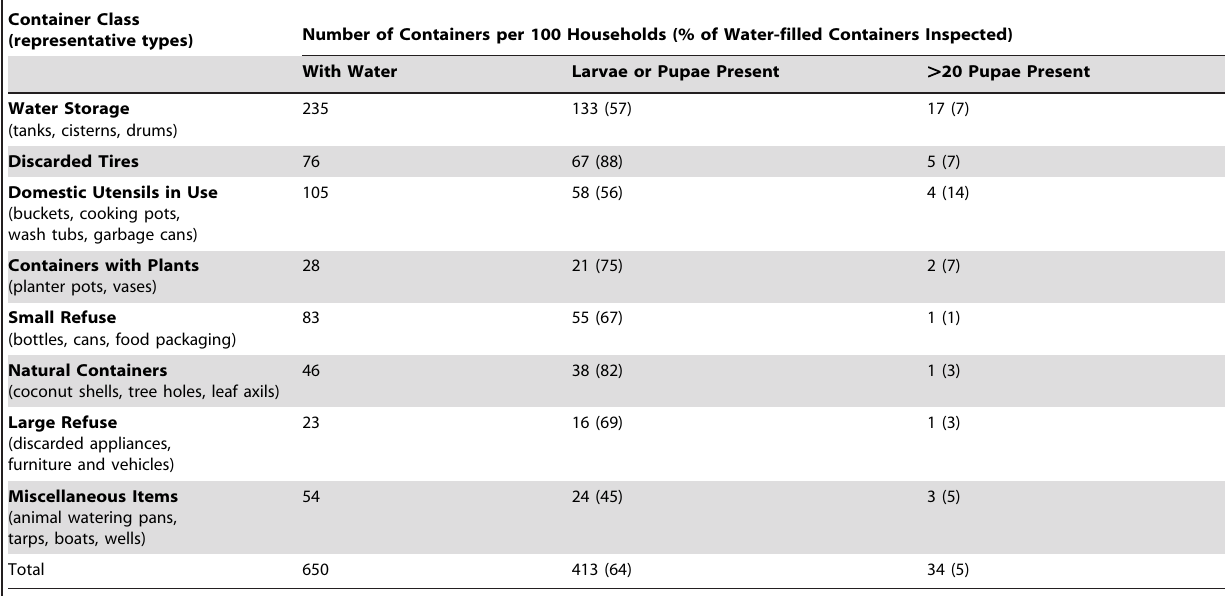
Table 2. Abundance and distribution of juvenile mosquitoes in water-filled containers identified during household surveys (N= 155) on Majuro atoll, Republic of the Marshall Islands, 3–8 November, 2011.